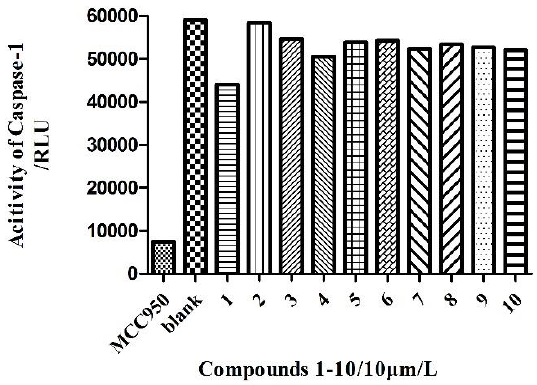
Figure 4. LPS-primed iBMDMs treated with 10 µ m / L of compounds 1 – 10 , and then stimulated with nigericin. The activity of caspase-1 was analyzed in the supernatant of BMDMs by the Caspase-Glo ® 1 Inflammasome Assay. RLU, recombinant luciferase, which is proportional to caspase-1 activity.